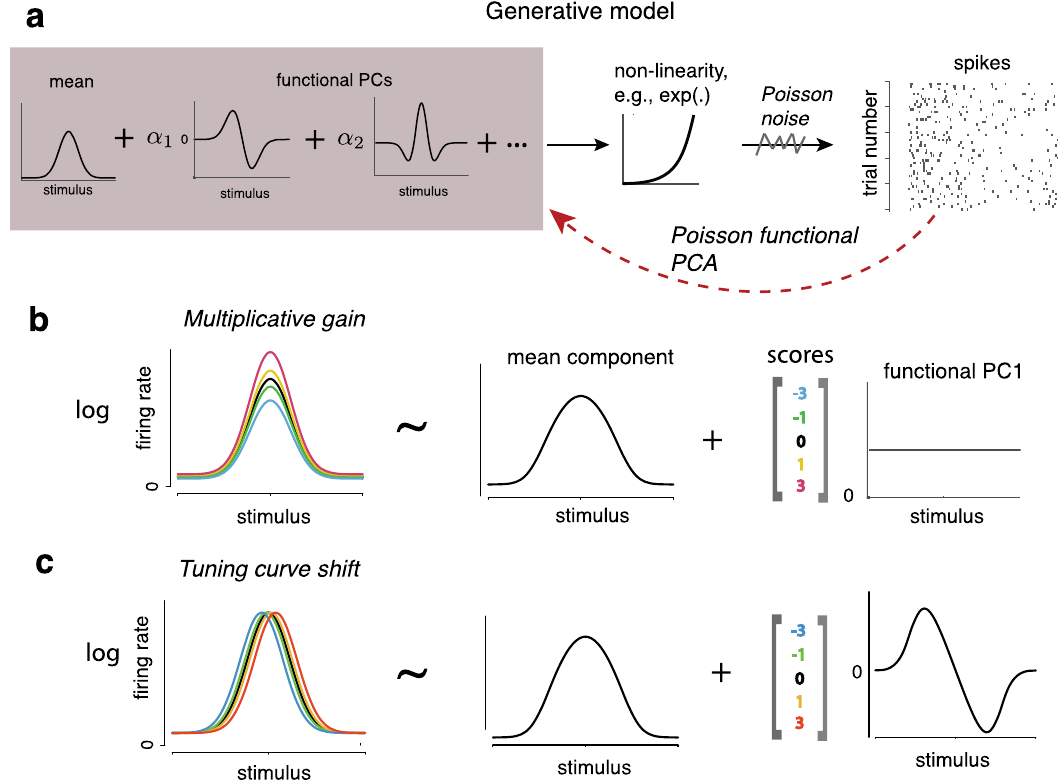
Fig. 1 | The Poisson functional PCA (Pf-PCA) framework. a Illustration of the Pf- PCA framework. Tuning functions (i.e., the logarithm of the tuning curves) are modeled as a sum of the mean and functional principal components (fPCs) weightedbytheamountoflatent fl uctuations α (i.e.,scores).Tuningfunctionsthen pass through a static non-linearity to obtain the tuning curves. The non-linearity is assumed to be an exponential function in this study. Finally, standard Poisson spikingnoiseisassumedforthegenerationoftheobservedspiketrains.ThePf-PCA algorithm performs inference on the observed spike counts. It extracts the mean component, the fPCs, and the moment-to-moment scores of each fPC.